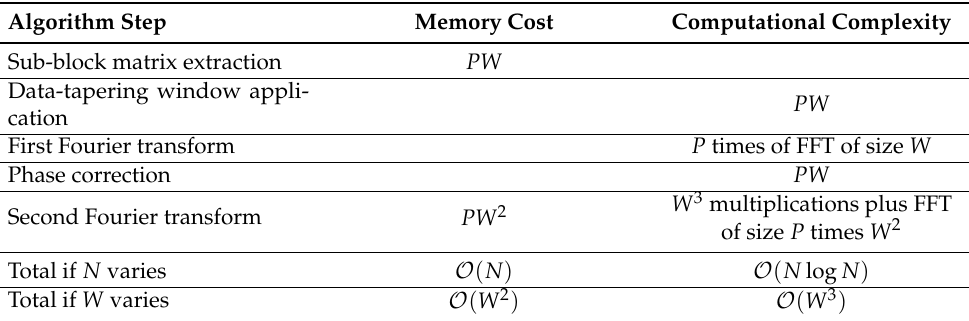
Table 1. Memory cost and computational complexity of the main steps in the FAM